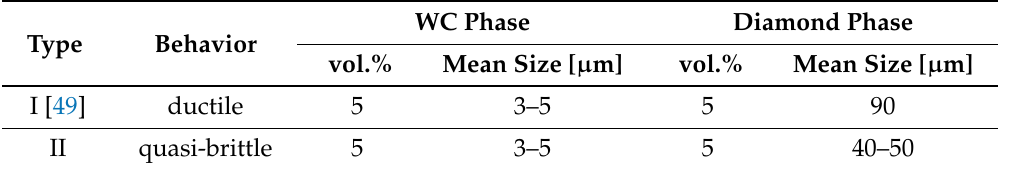
Figure 1. ( a ) Tensile sample geometry and purchased workpieces (showed quasi-brittle behavior) from company Effgen used in the current work; ( b ) samples including one after failure with another geometry together with the one in ( a ) for the same composite. Table 1. The composition and particle mean sizes (in diameter) of the two types of Co/WC/diamond composites with 90 vol.% Co, which the manufacturer provided.